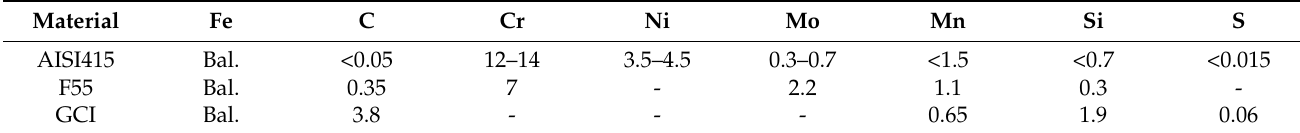
Figure 1. ( a ) Microstructure of the pearlitic cast-iron disc; ( b ) microstructure of the F55 granular powder. Table 1. Chemical composition of the coating materials and substrate